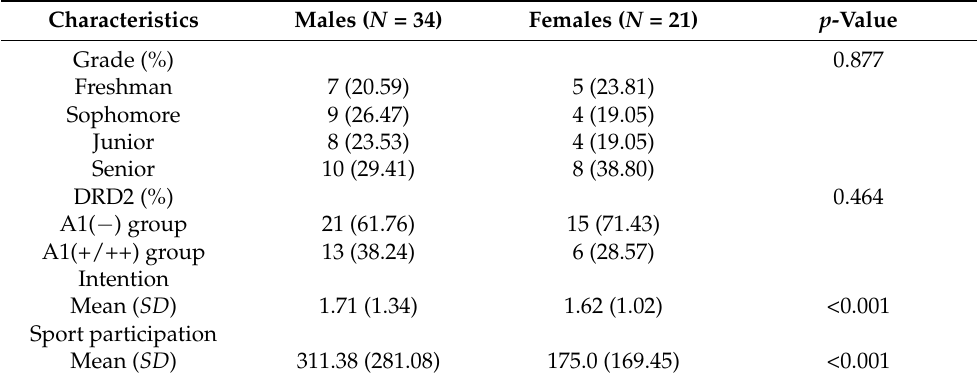
Table 1. Descriptive statistics.